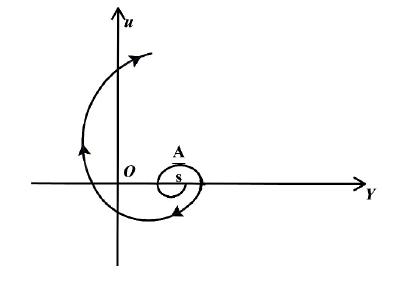
Fig. 6 Differential structure model of economic adjustment under unstable focus